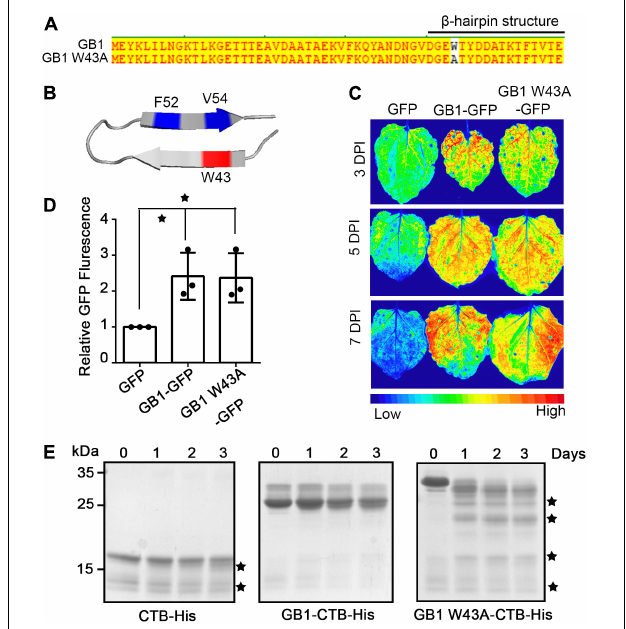
FIGURE 5 | The β -hairpin structure of GB1 is critical for the thermal stability of CTB but has no contribution to the increase in protein expression. (A) Protein sequences of GB1 and GB1[W43A]. (B) The β -hairpin structure of GB1. (C) Images of GFP fluorescence. The indicated constructs were expressed in Nicotiana benthamiana leaves, and images were taken at three DPI. (D) Quantification of GFP signals. GFP signals in Figure (C) were quantified and represented as relative values. The error bar is the mean ± SD ( n = 3). Single Asterisks indicate a significant difference (Student’s t -test, P < 0.05). (E) Thermal stability of GB1 and GB1[W43A]-fused CTB. The indicated constructs were expressed in N . benthamiana via Agrobacterium -mediated infiltration. Proteins were purified using Ni 2 + -NTA affinity column chromatography. Purified proteins (2 µ g) were incubated at 60 o C for 1, 2, and 3 days and separated by SDS-PAGE. The gel was stained with CBB. Black asterisks indicate protein breakdown